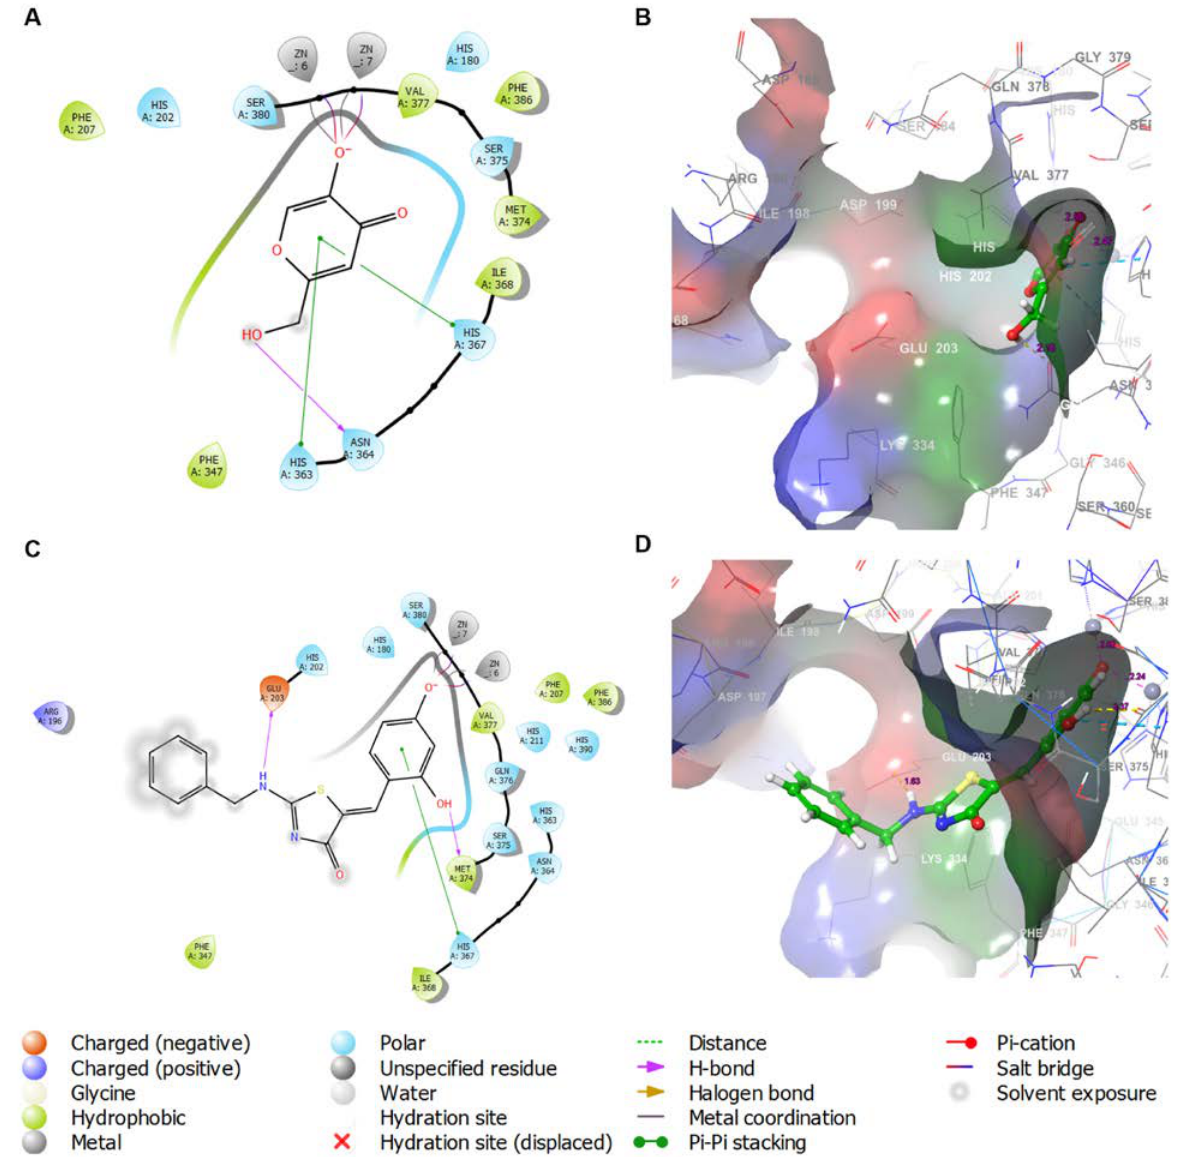
Figure 6. In silico docking simulation of kojic acid and 8 with the human tyrosinase homology model using the Schrödinger Suite. Binding interactions between the amino acid residues of human tyro- sinase and the ligands, kojic acid ( A , B ) and 8 ( C , D ), are displayed in 2D and